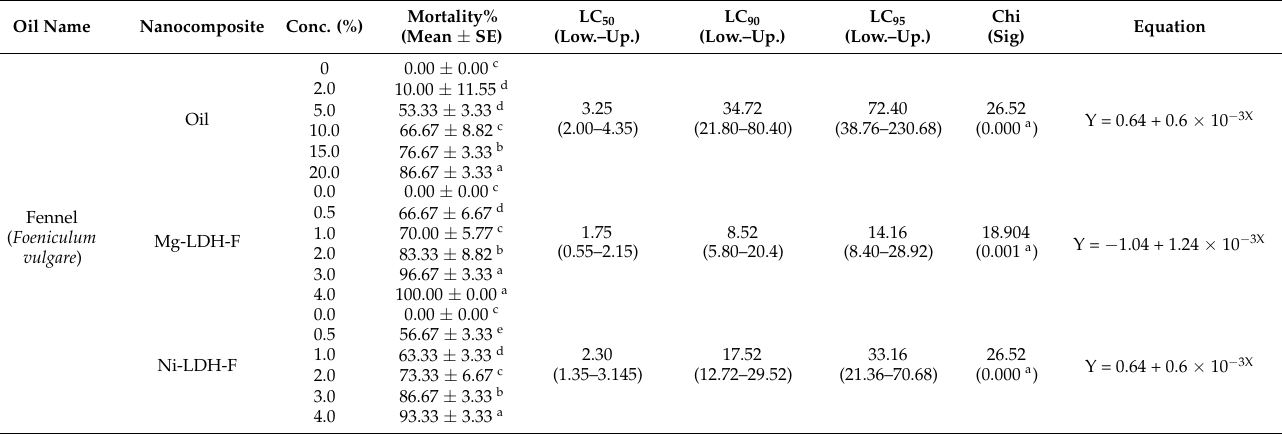
Table 5. The adulticidal effects of fennel oil and its LDH against adult Culex pipiens, 24 h post treatments.